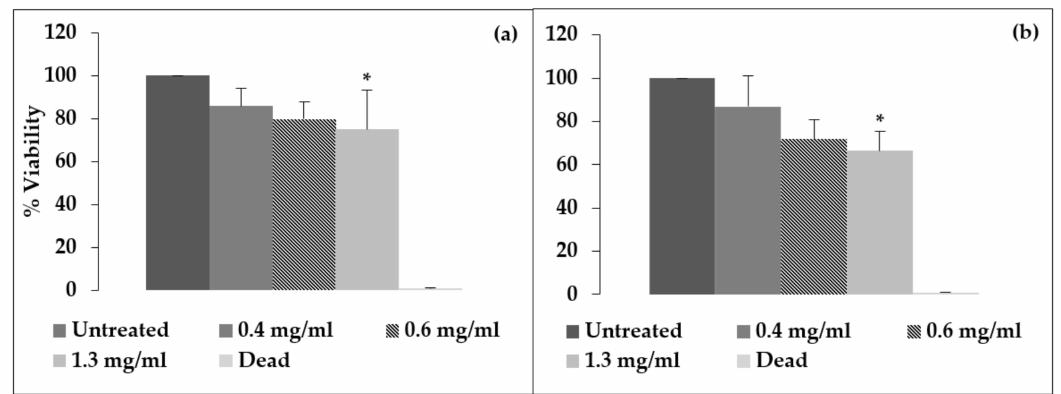
Figure 2. Percentage cell viability of immortalized human keratinocyte (HaCaT) cells after 48 h exposure to Aloe muth-muth gel ( a ) and Aloe muth-muth whole leaf ( b ) plant material. The data were normalized to the untreated control that is considered as 100% viable. The * indicates statistical significance in comparison to the untreated control (Bonferroni test, p <